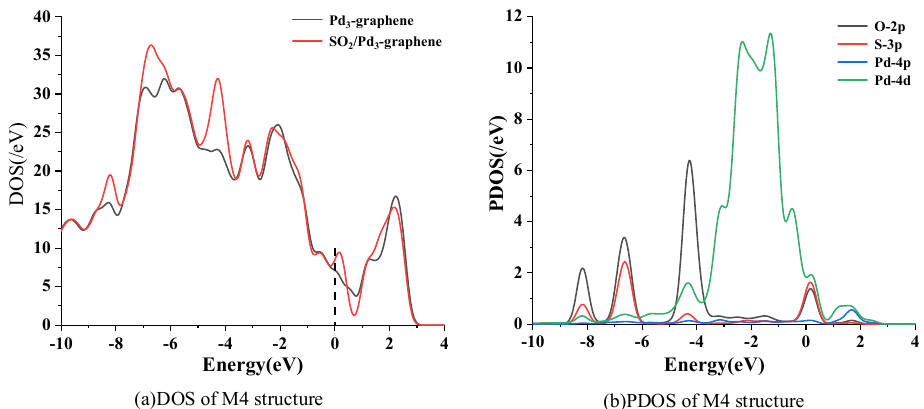
Figure 5. Density of states (DOS) and partial density of states (PDOS) of system M4. Dashed line represents the Fermi level.